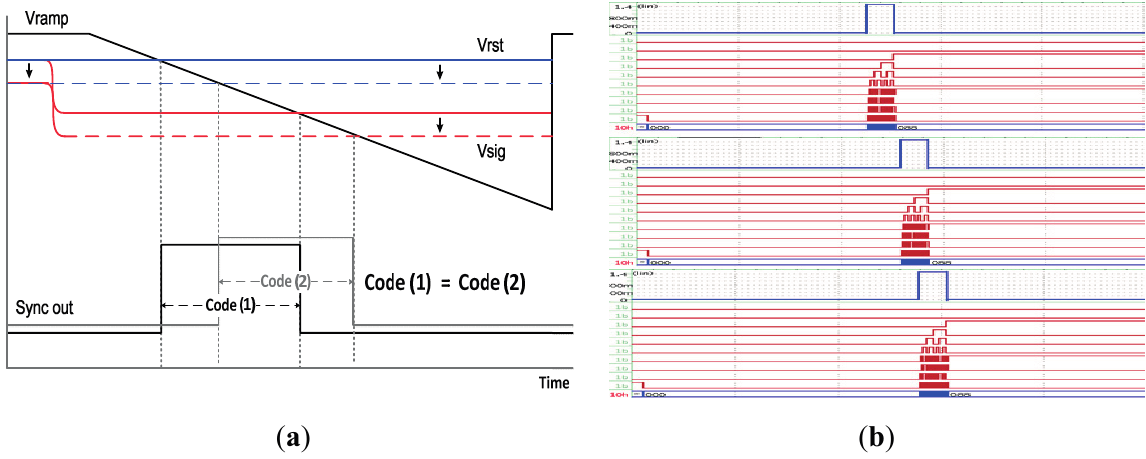
Figure 7. SPICE simulation results for the signal fluctuations at the novel digital CDS: ( a ) fluctuations of the reset signal and pixel signal; ( b ) the novel digital CDS keeps its original value, even though fluctuations are